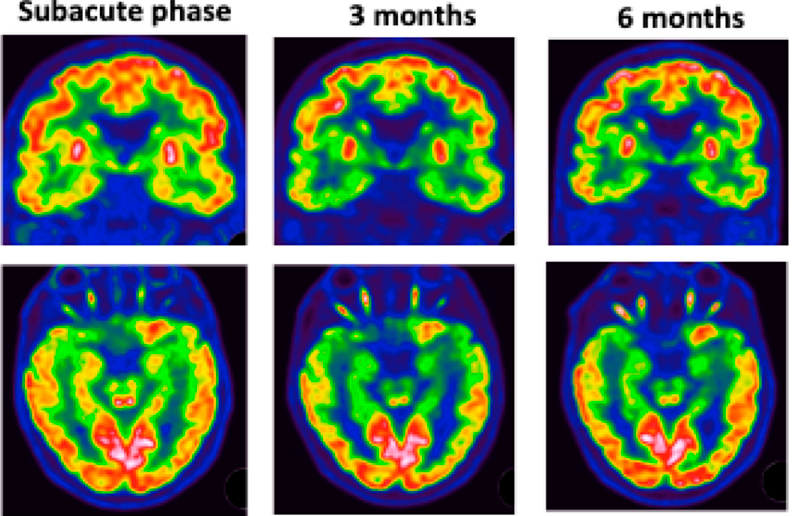
Figure 5. Patient #5: colliculus’s hypermetabolism and left medial temporal hypometabolism at subacute phase. These abnormalities worsened over time. Table 3. FDG-PET CT findings.